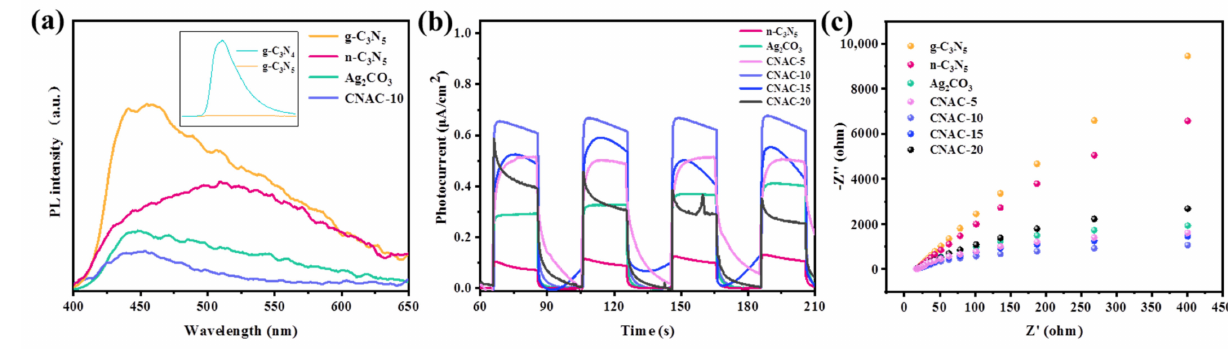
Figure 7. ( a ) PL spectra; ( b ) photocurrent response; and ( c ) EIS Nyquist